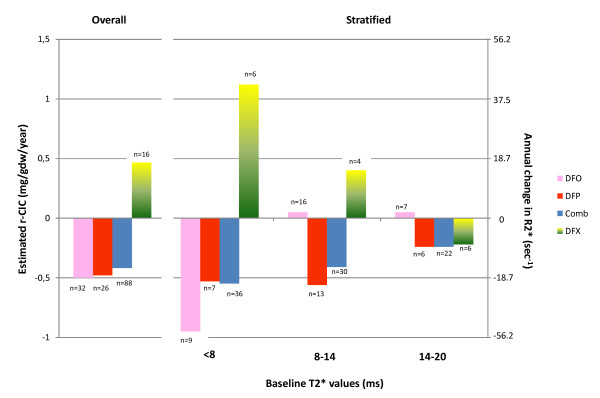
Annual rate of change of Estimated Cardiac Iron Concentration r-CIC comparing significance between the treatment regimes (Initial interval analysis). Significant comparisons (Mann Witney Test) • Overall: DFP -v- DFX p < 0.001, Comb -v- DFX p < 0.001 • Severe: Comb -v- DFX p = 0.04, DFX -v- DFO p = 0.07 (marginally non-significant) • Moderate: DFP -v- DFO p = 0.06, DFP -v- DFX p = 0.036, Comb -v- DFO p = 0.07, Comb -v- DFX p = 0.07 (both marginally non-significant) • Mild: No comparison was statistically significant.